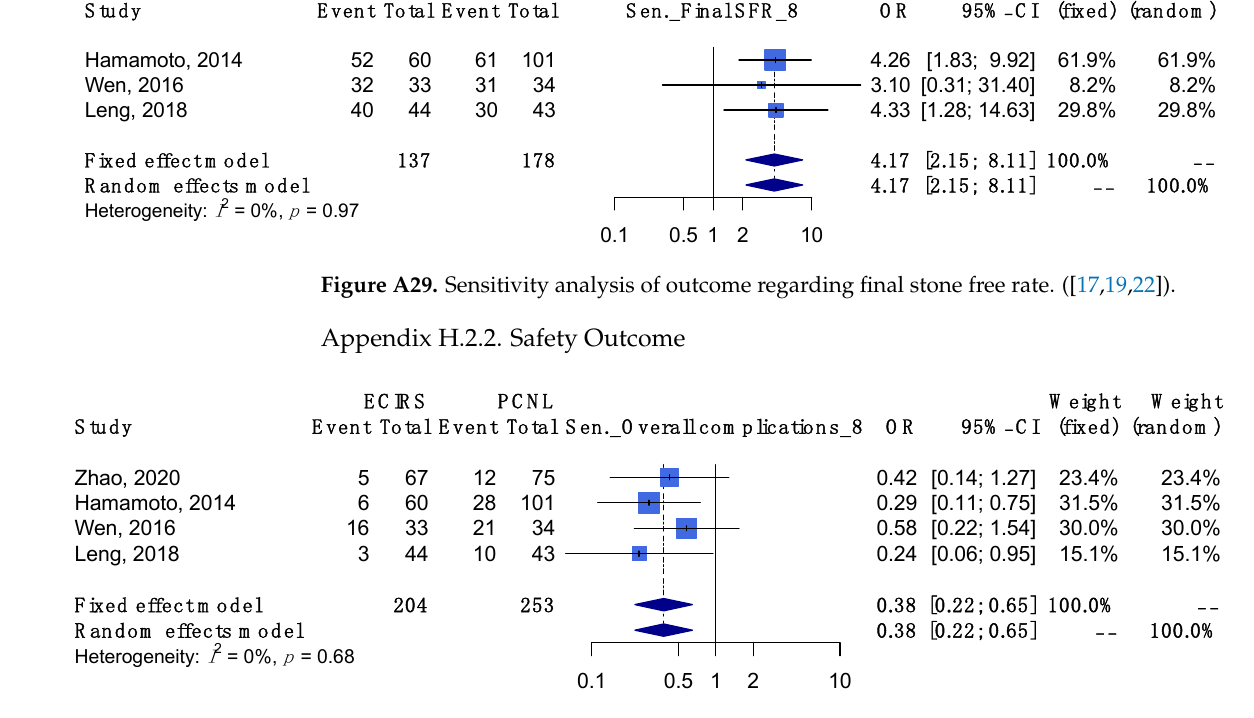
Figure A28. Sensitivity analysis of outcome regarding initial stone free rate. ([17–19,22])